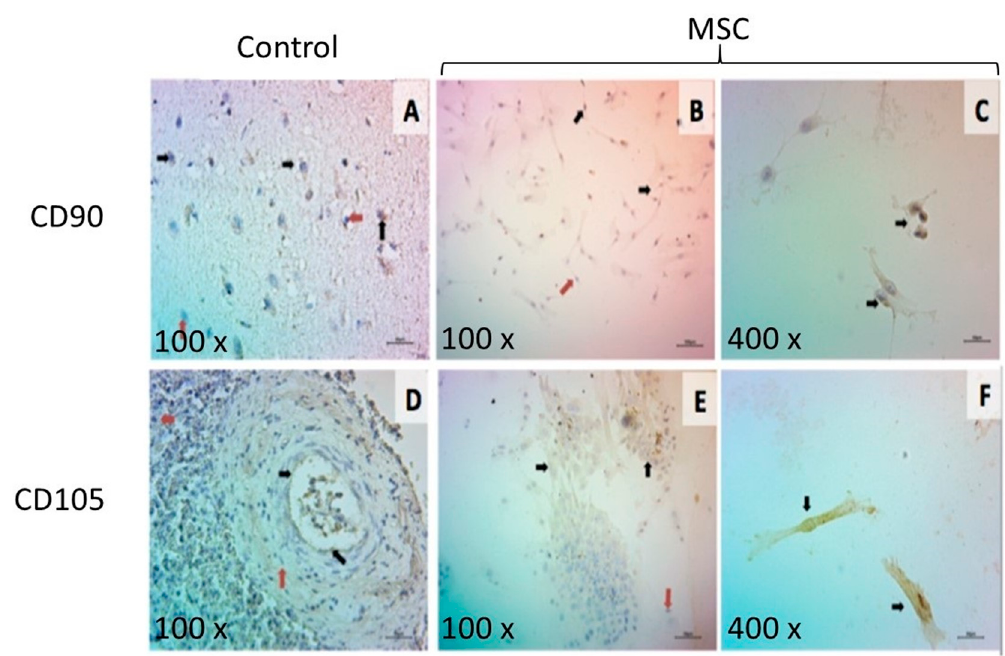
Figure 6. Immunocytochemistry characterization of a mesenchymal stem cell (MSC). ( A ) Ovine brain tissue positive for CD90; ( B , C ) MSC marked with CD90; ( D ) ovine spleen tissue positive for CD105 and ( E , F ) MSC marked with CD105.